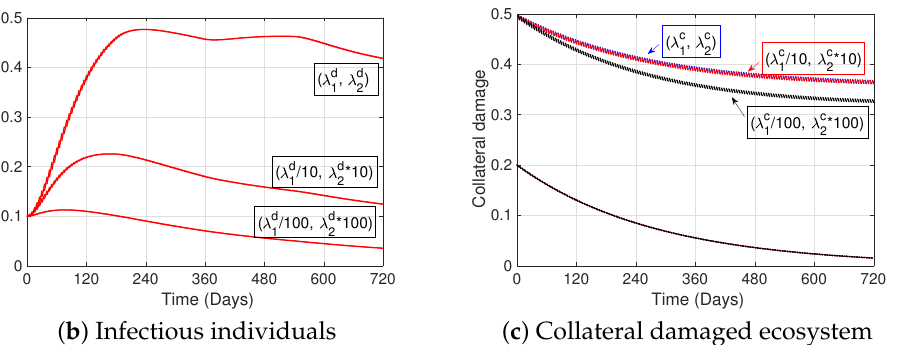
Figure 7. The figure shows the effect of risk perception on ( a ) cumulative chronic intoxication after long-term ITNs exposure, ( b ) malaria disease, and on ( c ) collateral damage ( D c ) of the ecosystem due to misuse of ITNs as fishing gear. The parameters λ k and λ k , with k = p , d , c , were reduced and 2 1 increased by a factor of 10 and 100, respectively. All other parameter values used are as in Figure 4. Finally, Figure 8 shows the effect of imposing fishing restrictions, in particular limiting ITN fishing. We observe that increasing the duration of closed fishing periods, of length ∆ t n , produces, on average, lower levels of damage to the aquatic ecosystem (average between lower lines and upper lines for each color), and also a spacing out of the dashes of the higher curves, representing time intervals with large collateral damage in each case. Hence, the longer the closed fishing periods, the lower the average collateral damage level and the shorter the timeframes producing large damage to the